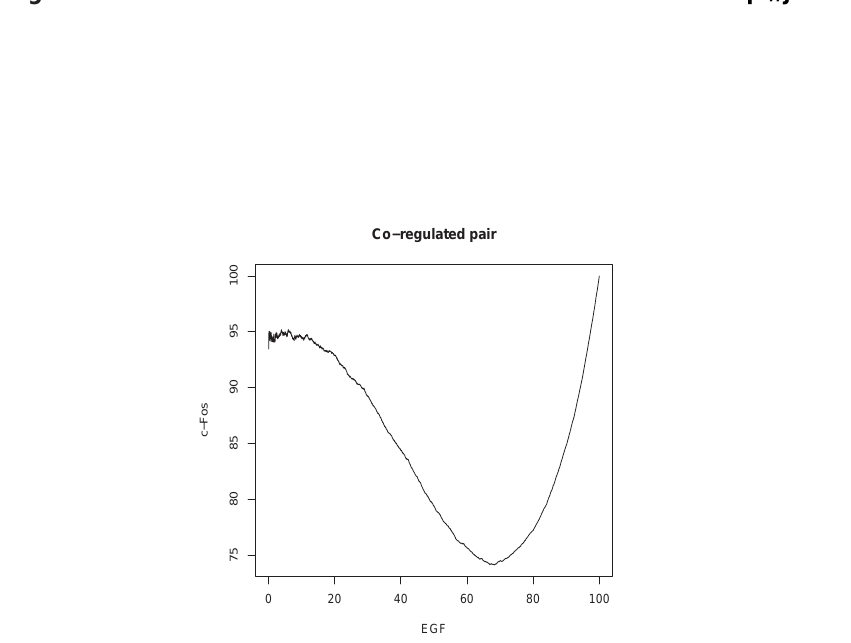
Figure 4: Plot of the co-regulation of EGF versus c-Fos proteins in the MAPK pathway under the second scenario and t = 20 . The axes show the number of molecules of substrates through time.